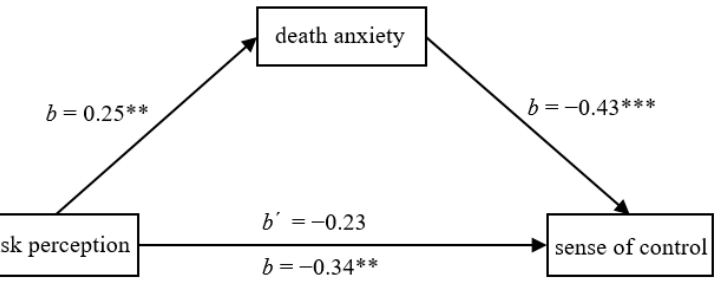
Figure 3. Death anxiety mediated the effect of risk perception on sense of control in Study 4. ** p <0.01, *** p < 0.001.